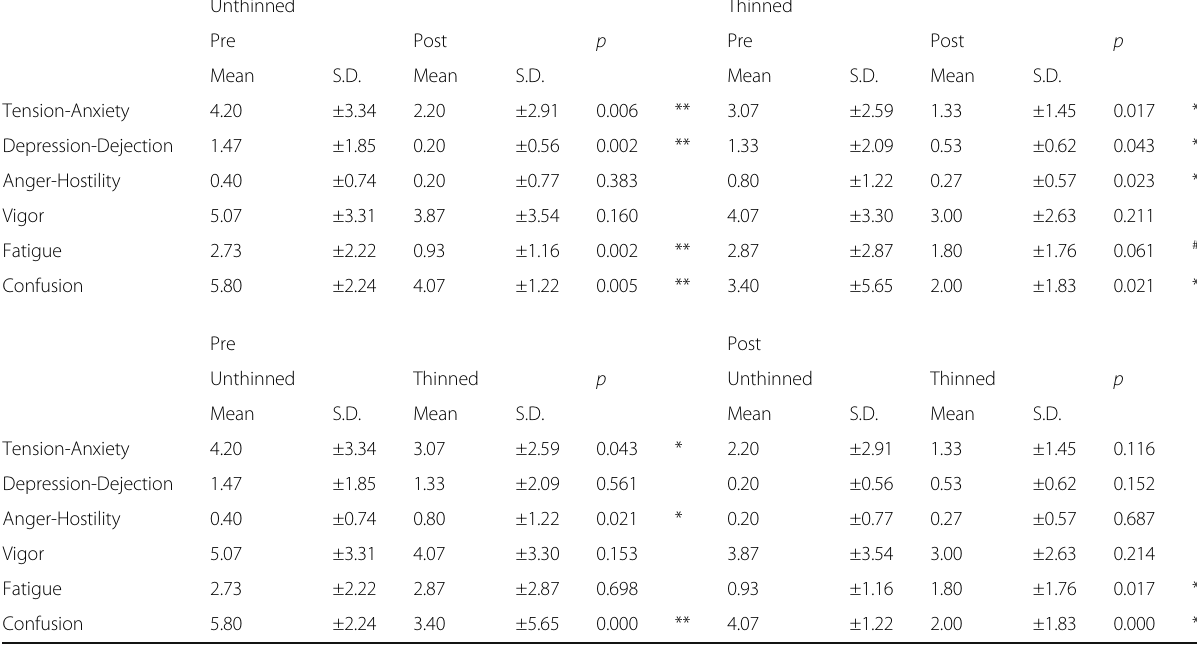
Table 8 Results of multiple comparison tests between before and after thinning (setting) and pre – post (exposure to the forest) for Profile of Mood States